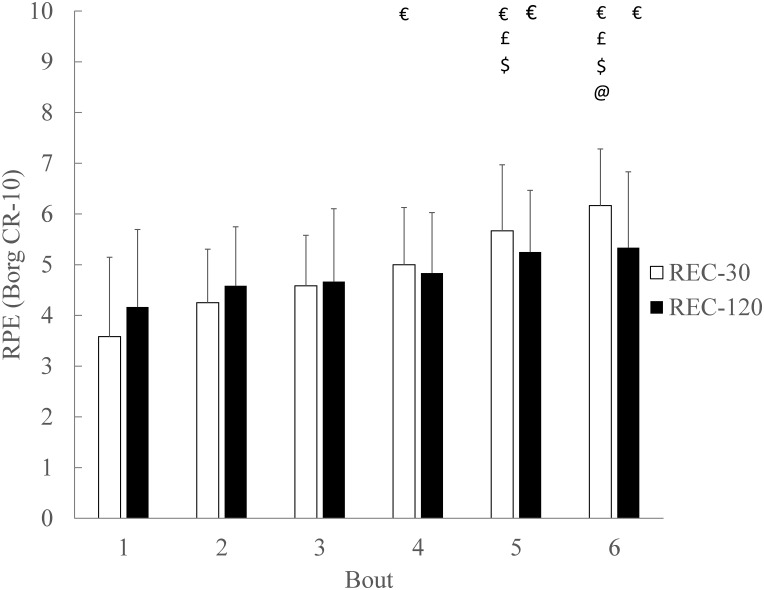
Rating of perceived exertion (RPE) during SSG bouts.There was no significant main effect (p > .05) of condition on RPE. There was a significant main effect (p < .05) of bout number, with an increase in RPE across the bouts. There was a significant (p < .05) condition x bout interaction for RPE. Data are mean ± SD. Symbols denote significant differences from post hoc pairwise comparisons (€) to B1, (£) to B2, ($) to B3 and (@) to B4.